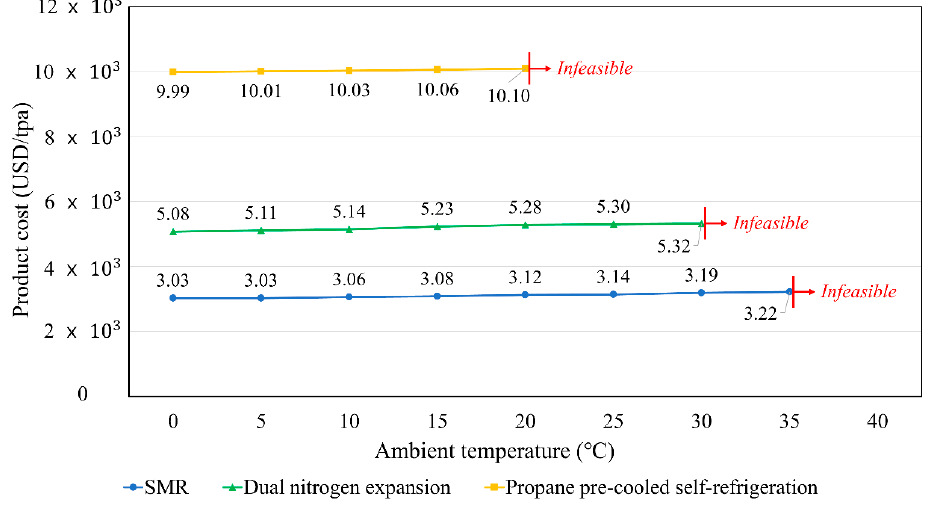
Figure 14. Effects of ambient temperature on product cost of each process.